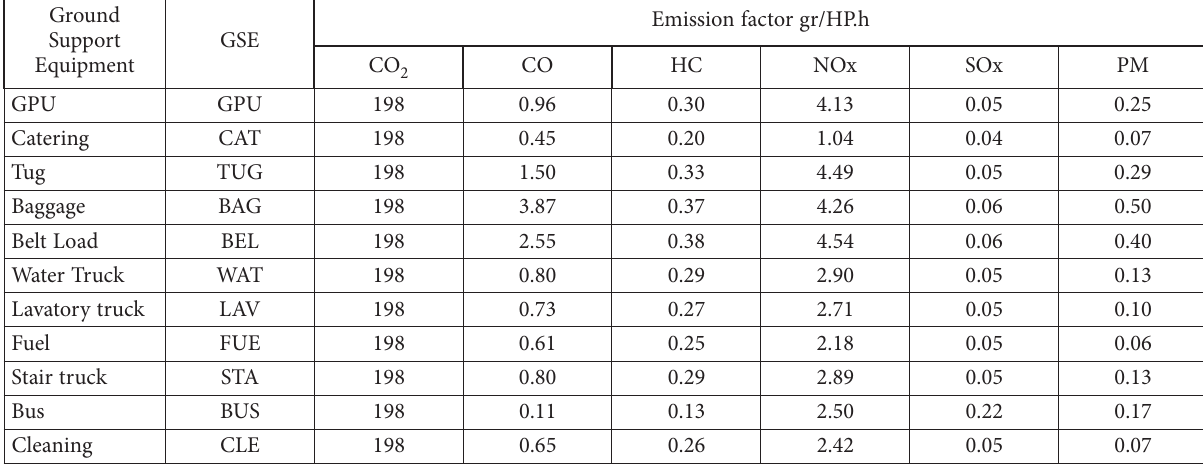
Table 6. Emission factors per gas analyzed (source: U.S. Department of Transportation (2019) and US EPAs (United States Environmental Protection Agency (2010))